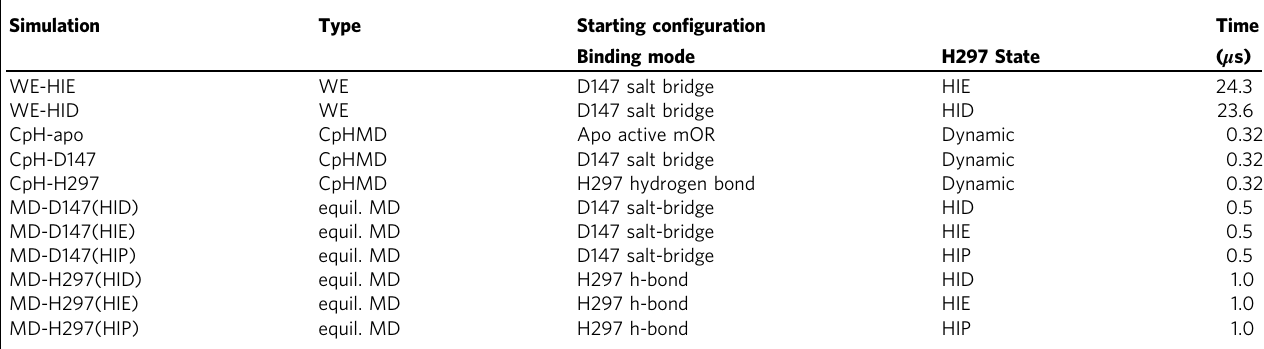
Table 1 Summary of simulations in this